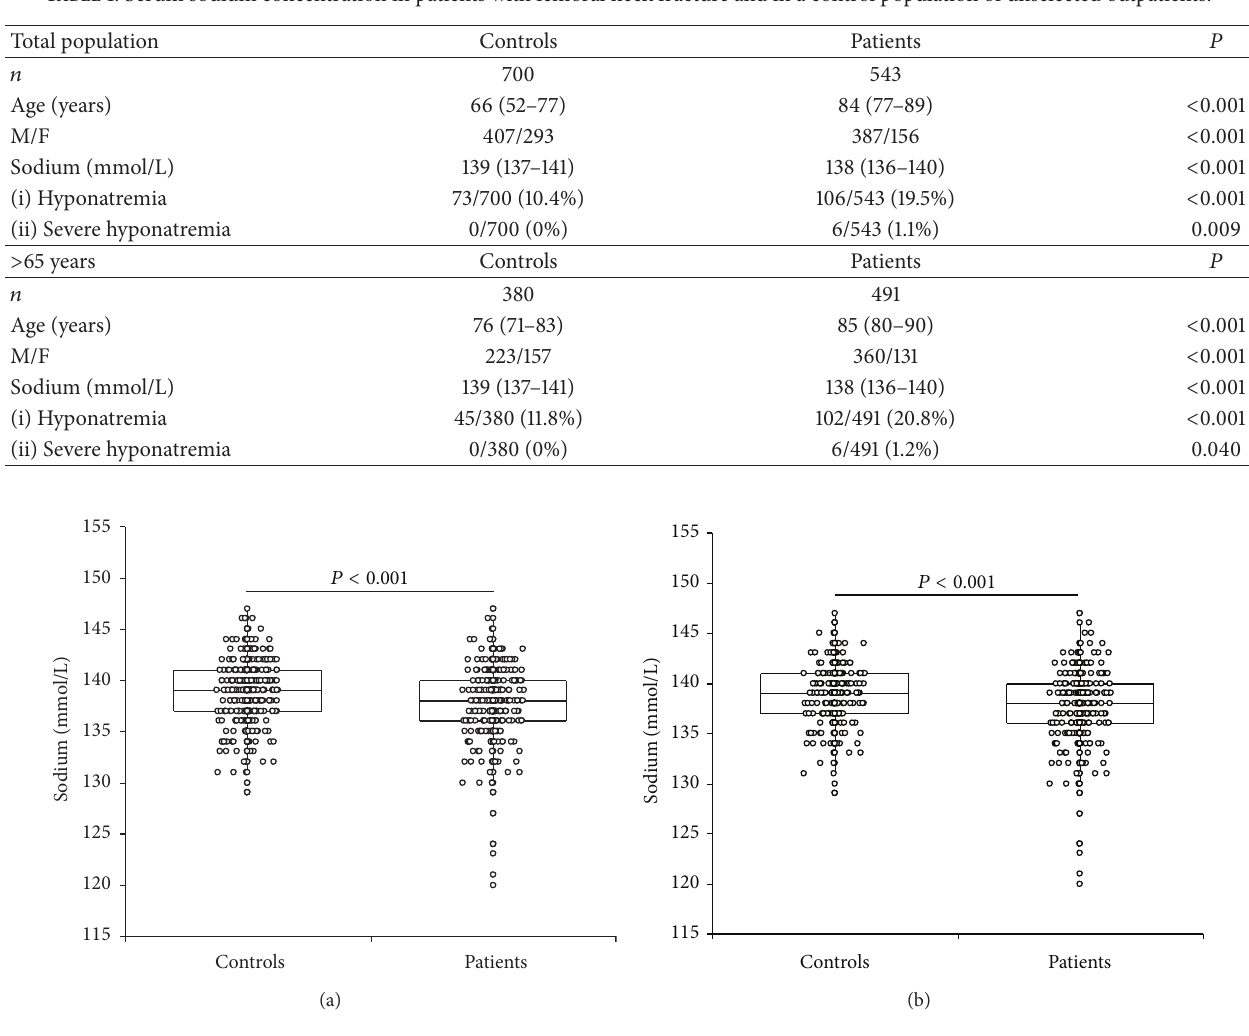
Figure 1: Serum sodium concentration in patients with femur neck fracture and in a control population of unselected outpatients. (a) Whole population and (b) subjects aged 65 years or